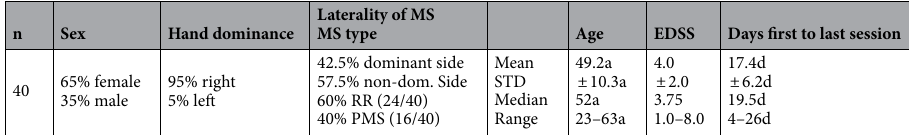
Table 2. Sample characteristics: ratios, means, standard deviations, and ranges. RR relapsing remitting MS, PMS progressive